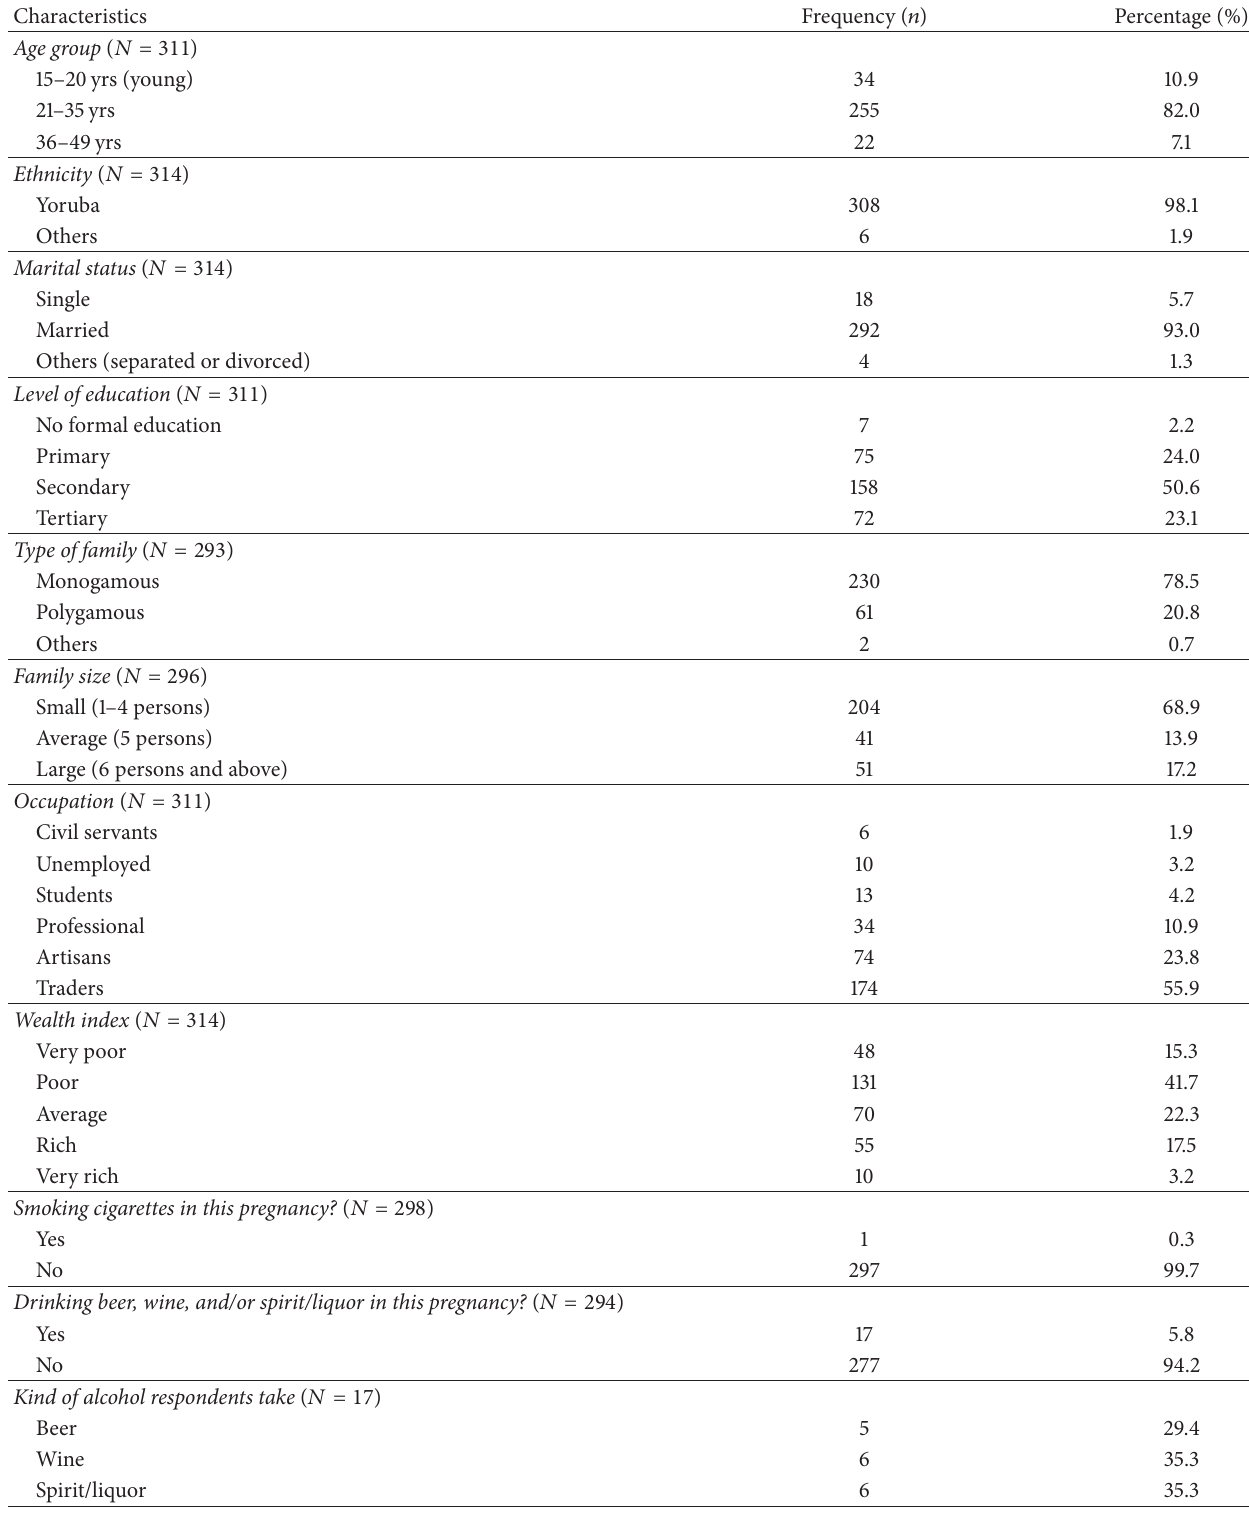
Table 1: Frequency distribution of the sociodemographic characteristics of the